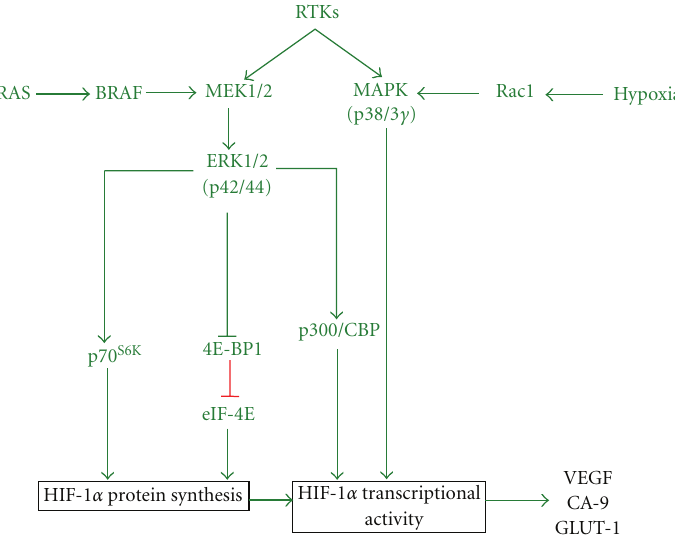
Figure 2: Regulation of HIF-1 α by the MAPK pathway. Stimulation of receptor tyrosine kinases (RTKs) by growth factors, or activating mutations in the RAS family of GTPases, such as KRAS, results in activation of a range of MAPK-signalling proteins. Activation of ERK1/2 by MEK1/2 increases HIF-1 signalling (a) by phosphorylating and promoting the interaction of the coactivator p300 with HIF-1 α and (b) by phosphorylating and activating the translational regulatory protein p70 S6K and by phosphorylating and disrupting the repressive interaction of 4E-BP1 with eIF-4E. Activation of these translational machinery proteins leads to increased protein synthesis of HIF-1 α . Activation of MAPKs (p38/p38 γ ) leads to the direct phosphorylation and activation of HIF-1 α . Additionally, under hypoxia, activation of the small GTPase Rac1 leads to a Rac1 dependent increase in HIF-1 α activity via Rac-1 induced activation of p38 MAPK. Genetic mutations in members of the MAPK signalling pathway such as those in BRAF (BRAF V600E ) lead to hyperactive MEK/ERK signalling and enhanced HIF-1 α